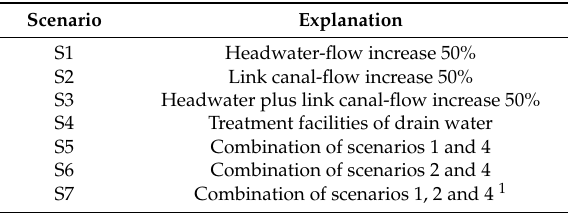
Table 2. Scenarios designed in this study for water-quality